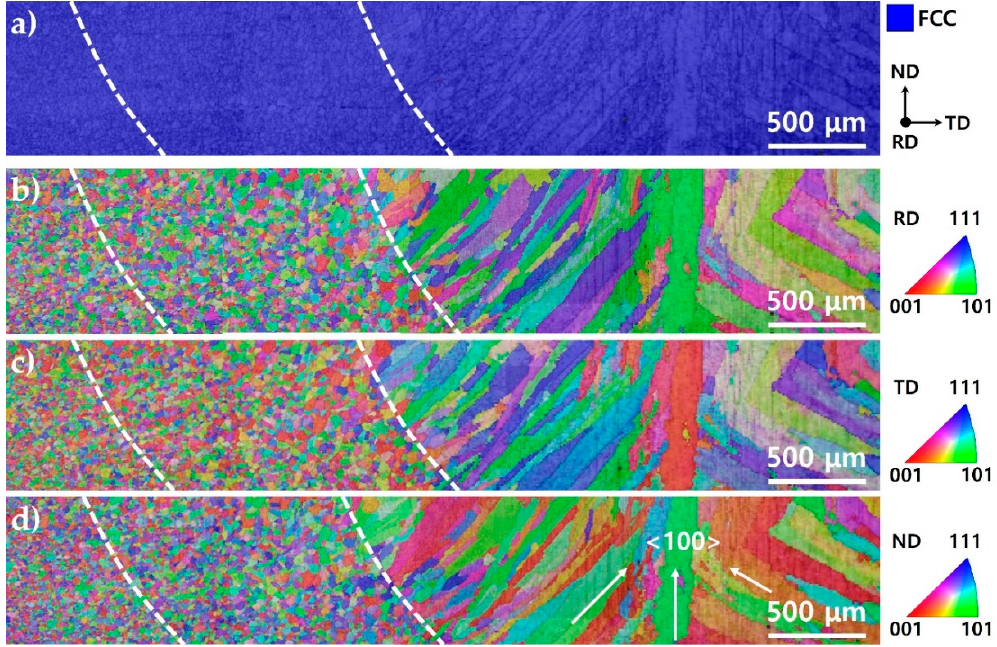
Figure 6. EBSD analysis results of the as-welded steel: ( a ) phase map, ( b – d ) inverse pole figure (IPF) maps at rolling direction, transverse direction, and normal direction, respectively.